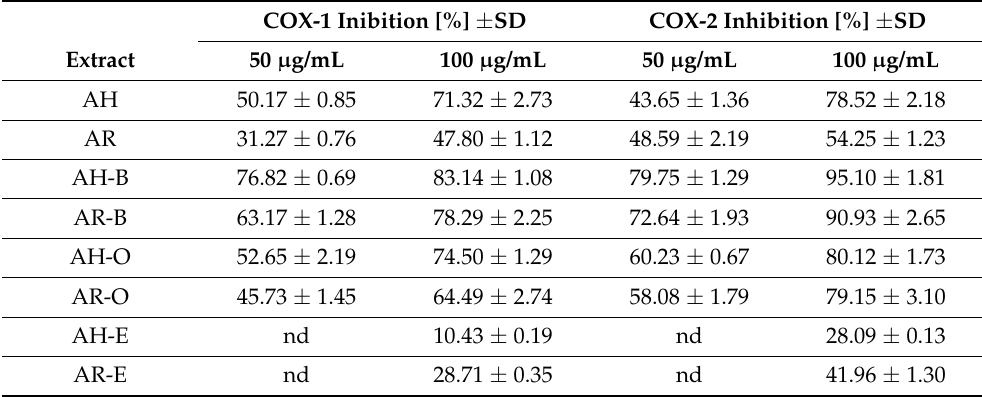
COX-1 Inibition [%] ± SD